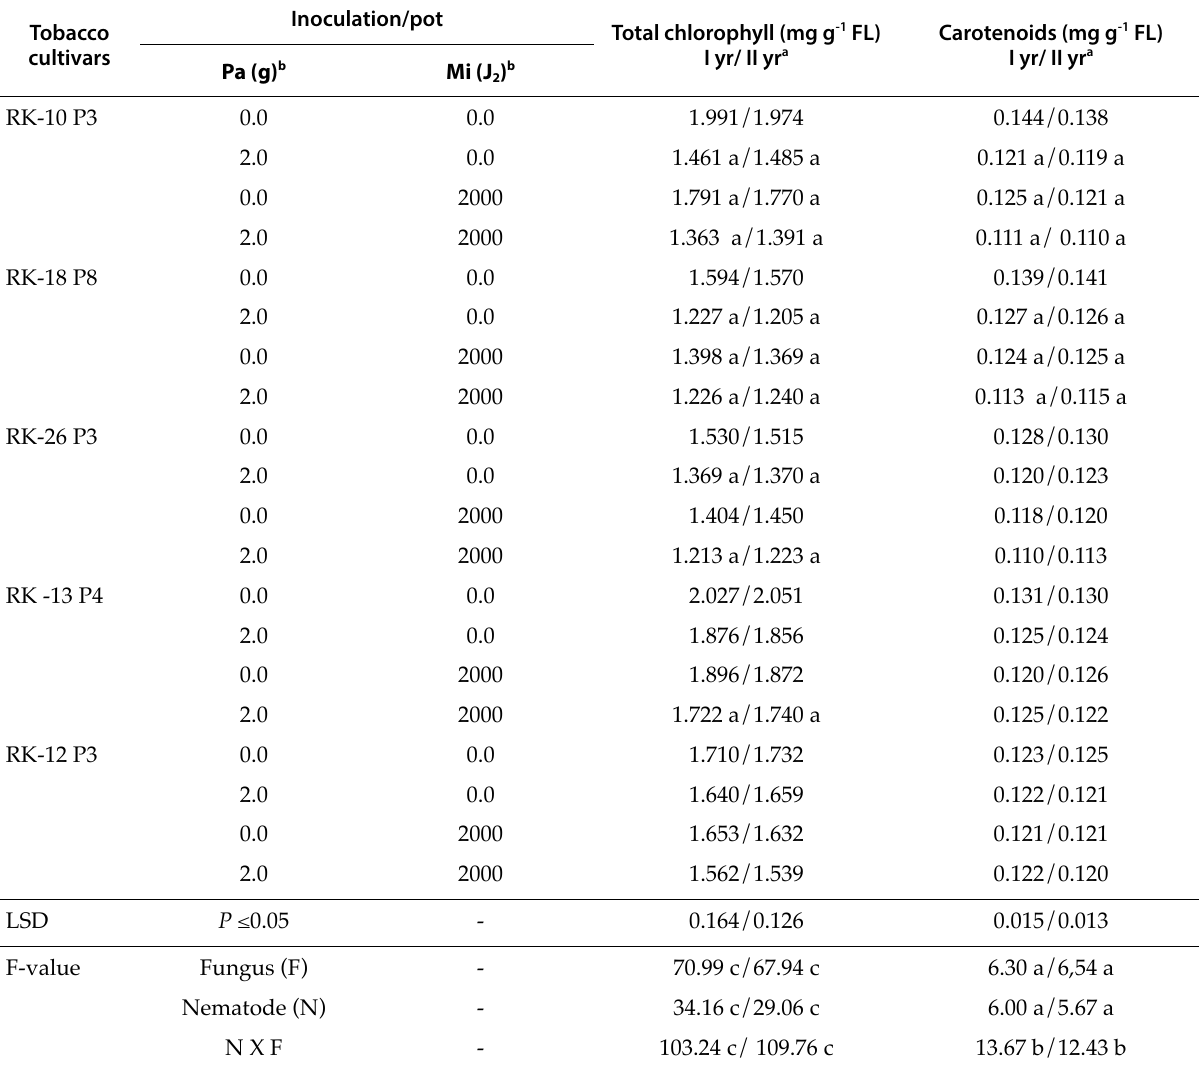
Table 3. Mean amounts of leaf pigments in different tobacco cultivars inoculated with Pythium aphanidermatum or Meloido- gyne incognita as single or concomitant inoculations. Tobacco